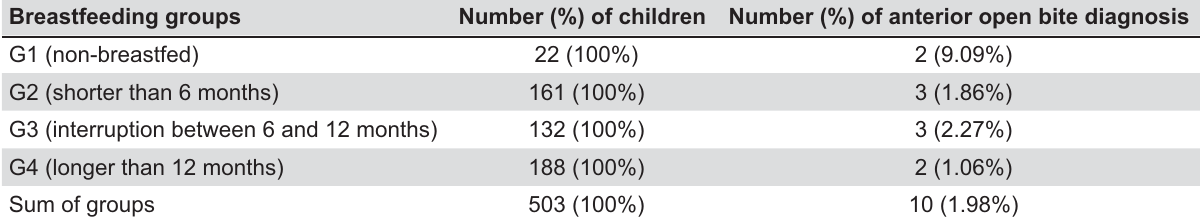
Table 7- (cid:2)(cid:27)(cid:7)(cid:15)(cid:24)(cid:6)(cid:9)(cid:15)(cid:5)(cid:14)(cid:15)(cid:2)(cid:10)(cid:16)(cid:2)(cid:6)(cid:5)(cid:13)(cid:15)(cid:7)(cid:4)(cid:10)(cid:7)(cid:2)(cid:10)(cid:23)(cid:15)(cid:5)(cid:2)(cid:21)(cid:4)(cid:13)(cid:15)(cid:2)(cid:6)(cid:14)(cid:14)(cid:10)(cid:7)(cid:22)(cid:4)(cid:5)(cid:11)(cid:2)(cid:13)(cid:10)(cid:2)(cid:21)(cid:7)(cid:15)(cid:6)(cid:12)(cid:13)(cid:16)(cid:15)(cid:15)(cid:22)(cid:4)(cid:5)(cid:11)(cid:2)(cid:22)(cid:20)(cid:7)(cid:6)(cid:13)(cid:4)(cid:10)(cid:5)(cid:2)(cid:4)(cid:5)(cid:2)(cid:14)(cid:18)(cid:4)(cid:9)(cid:22)(cid:7)(cid:15)(cid:5)(cid:2)(cid:28)(cid:4)(cid:13)(cid:18)(cid:10)(cid:20)(cid:13)(cid:2)(cid:18)(cid:4)(cid:12)(cid:13)(cid:10)(cid:7)(cid:8)(cid:2)(cid:10)(cid:16)(cid:2)(cid:23)(cid:6)(cid:14)(cid:4)(cid:29)(cid:15)(cid:7)(cid:2)(cid:6)(cid:5)(cid:22)(cid:30)(cid:10)(cid:7)(cid:2) (cid:29)(cid:5)(cid:11)(cid:15)(cid:7)(cid:25)(cid:12)(cid:20)(cid:14)(cid:26)(cid:4)(cid:5)(cid:11)(cid:2)(cid:18)(cid:6)(cid:21)(cid:4)(cid:13)(cid:12)(cid:2)(cid:31)(cid:5)!"#$& Breastfeeding groups